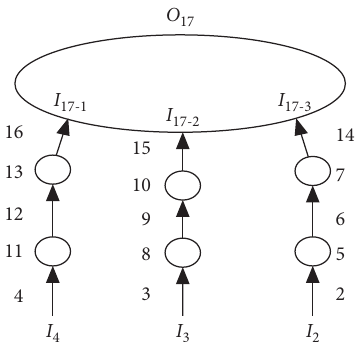
Figure 4: Topology diagram of the parallel